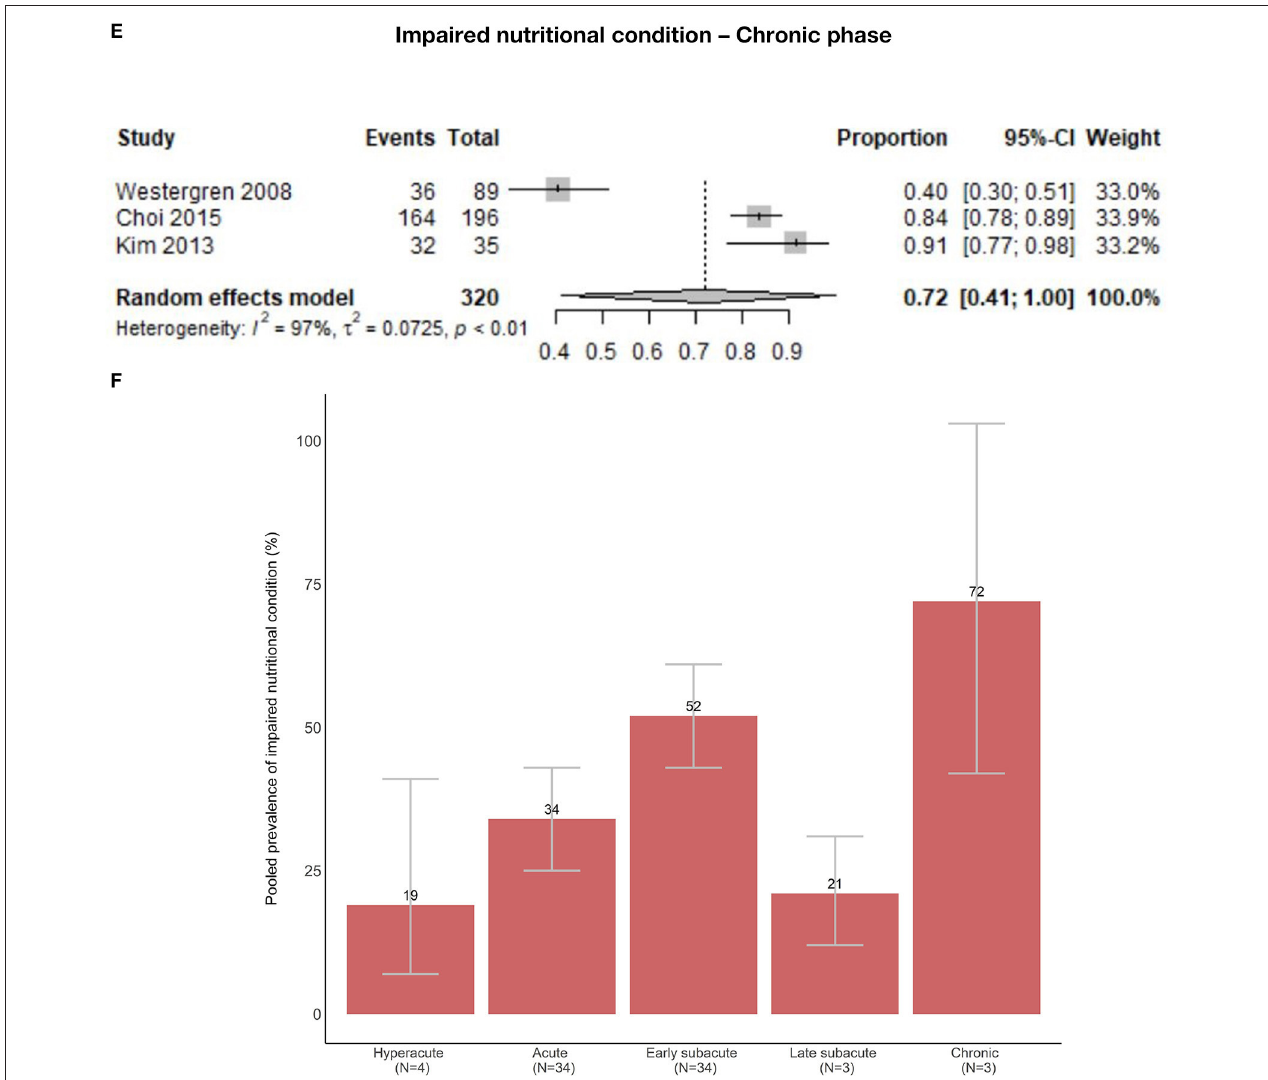
( Supplemental Figure 2 ). In the continents where the